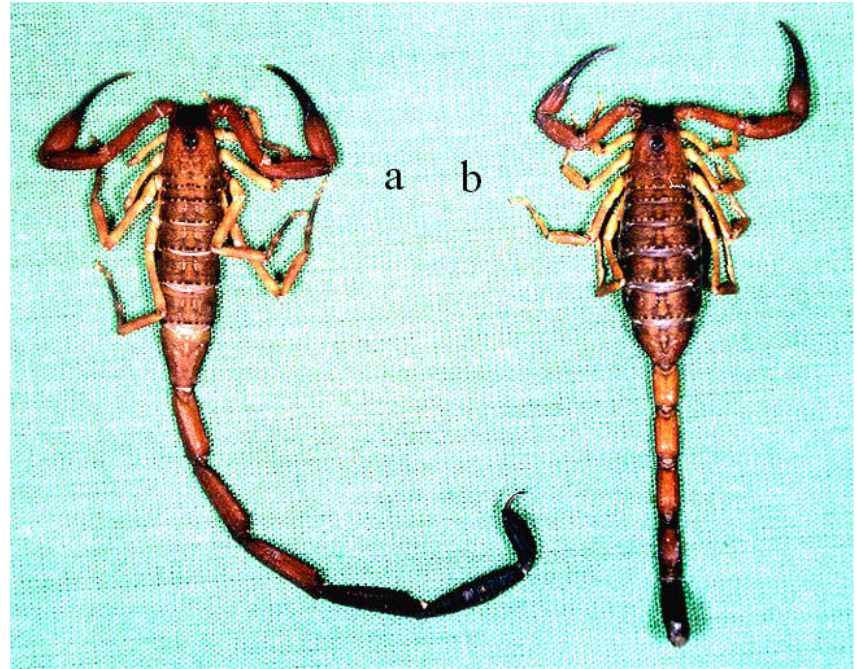
Figure 2 . Tityus gonzalespongai n. sp . a. Male (Holotype: CELT-126). b. Female (Paratype: